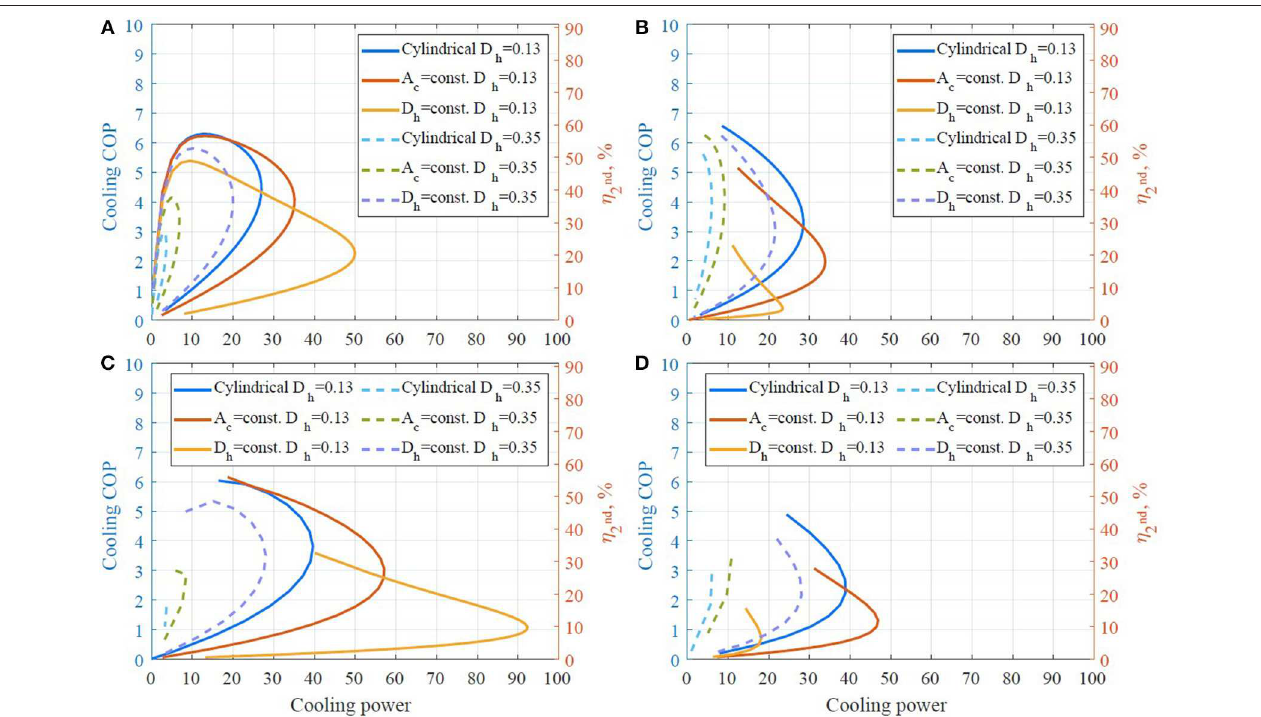
FIGURE 8 | Cooling COP as a function of cooling power at ε = 0.27. (A) Cassette 1, ν = 0.5Hz, (B) cassette 2, ν = 0.5Hz, (C) cassette 1, ν = 2Hz, (D) cassette 2, ν = 2